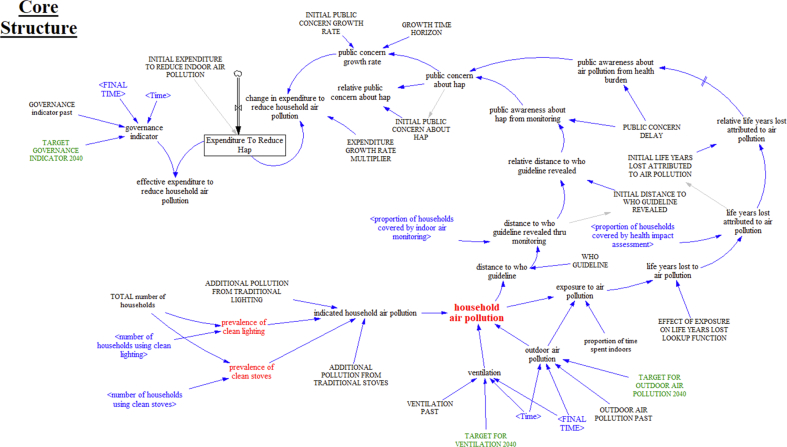
Core structure of the model.